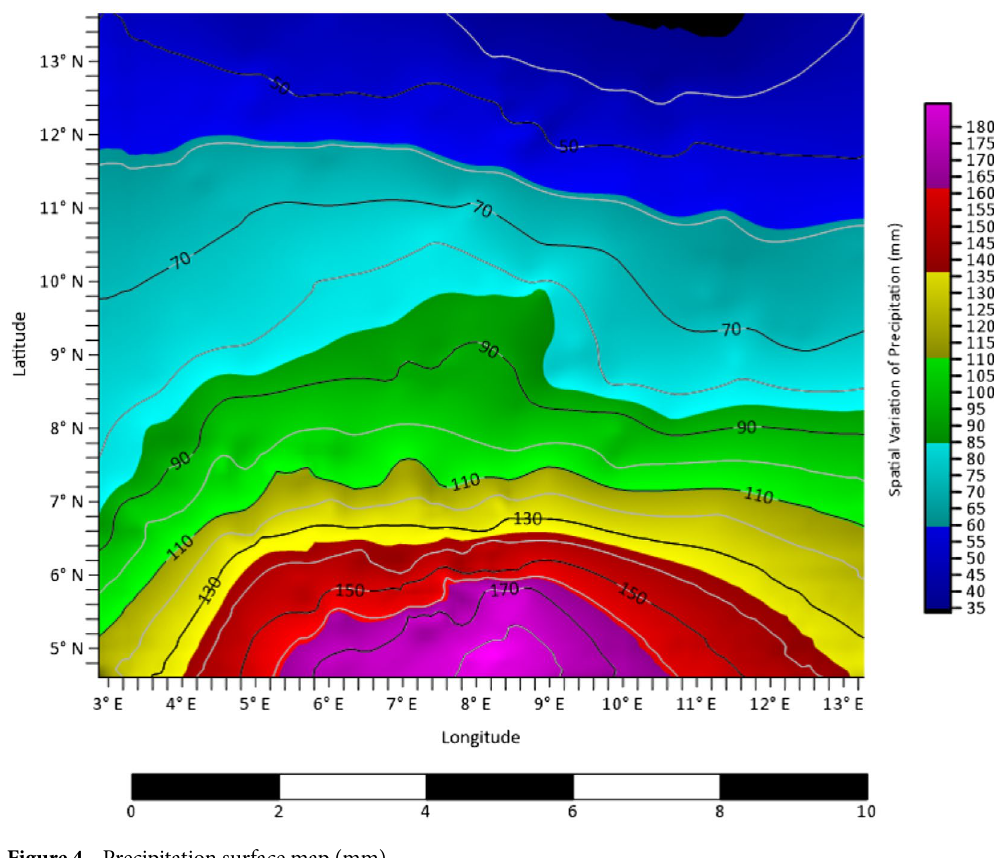
Figure 4. Precipitation surface map (mm).